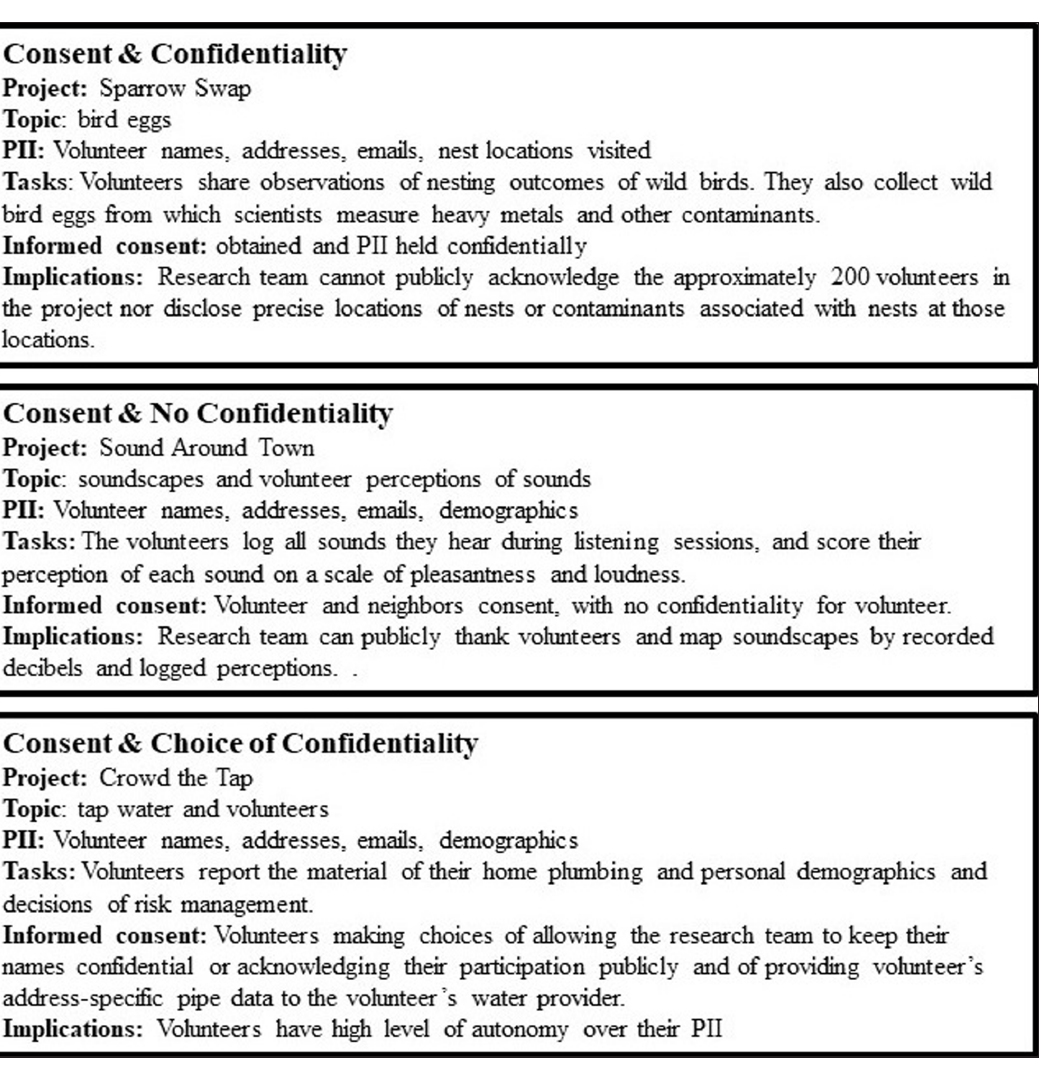
Figure 2: Examples of Type 4 projects from the Cooper Citizen Science Lab. Volunteers in all projects share personally identifiable information, and NC State University IRB reviewed protocols for each as human subjects research. Pro- jects are in chronological order of their development, which shows that the IRB and Cooper applied a progression of different norms to these